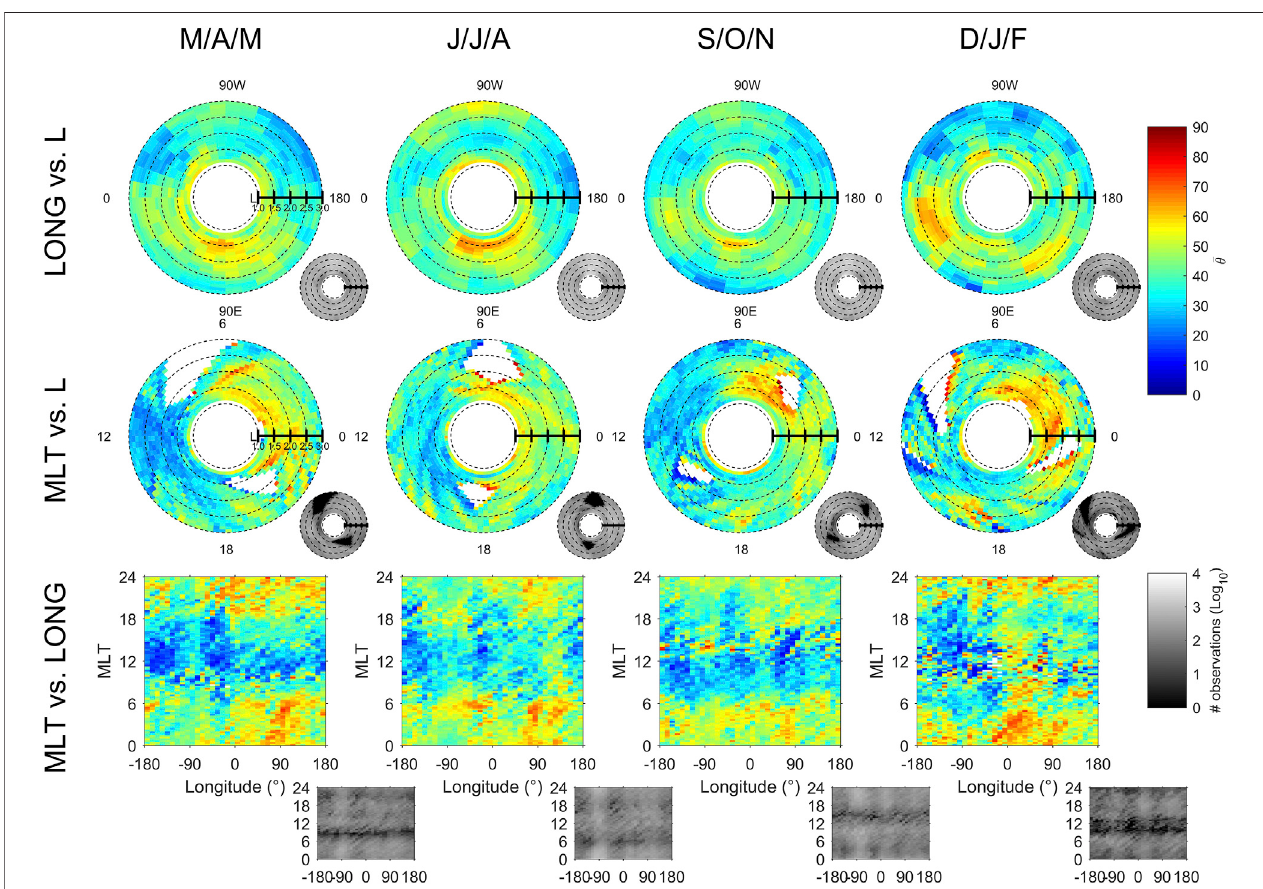
FIGURE 7 | Column table of graphic pairs. Each pair has a large map depicting the Van Allen Probes mean wave-normal angle ( θ ) of lightning-generated whistlers (in ° ), a lower right auxiliary map depicting the Probes coverage in number of observations. Columns correspond to four seasons (with M/A/M for March/April/May, etc.), and rows show the wave normal angle marginalized over MLT (i.e. plotted versus longitude and L-shell), longitude, and L-shell